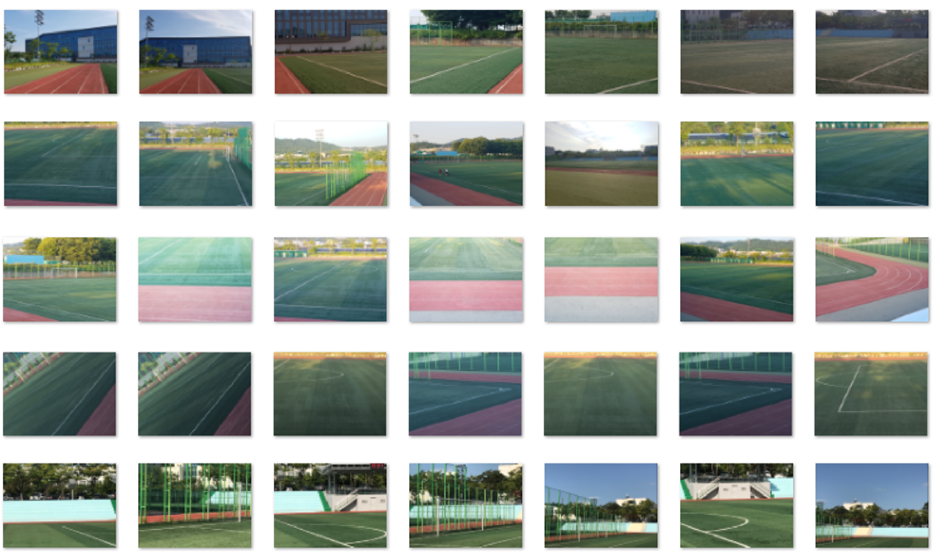
Figure 5. Image database for training of semantic segmentation module.